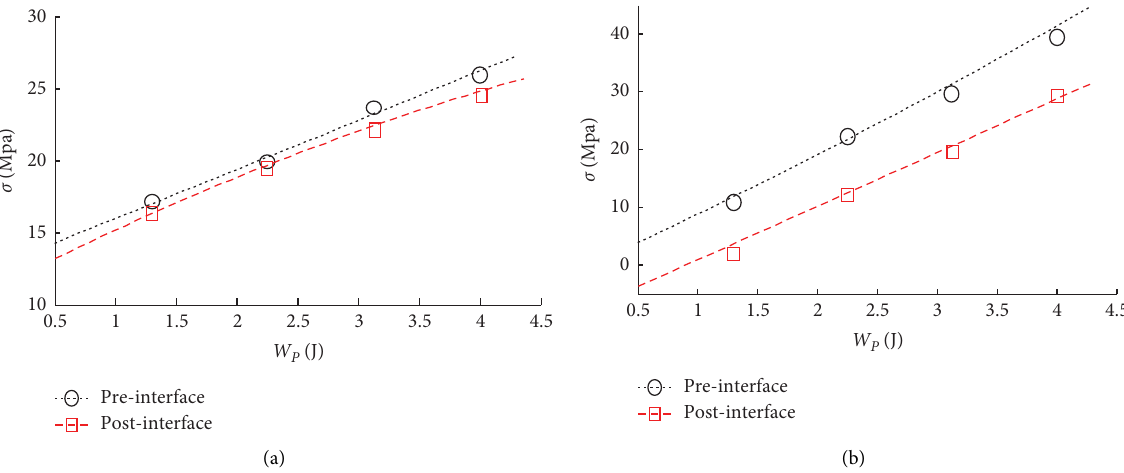
Figure 14: The impact stress transfer characteristics at the drilling tool joints. (a) The impact stress at the flange interface. (b) The impact stress at the screw interface.